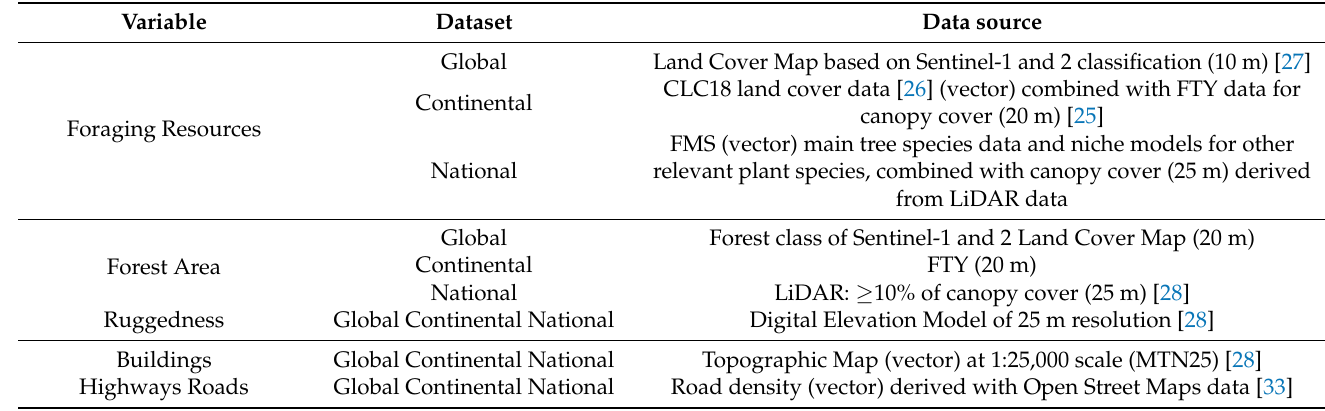
Table 1. Environmental variables for the three datasets according to their spatial coverage (global, continental or national). More details can be seen in the Materials and Methods section and Figure 1. Acronyms are Forest Type Product (FTY), Corine Land Cover 2018 (CLC18) and Forest Map of Spain